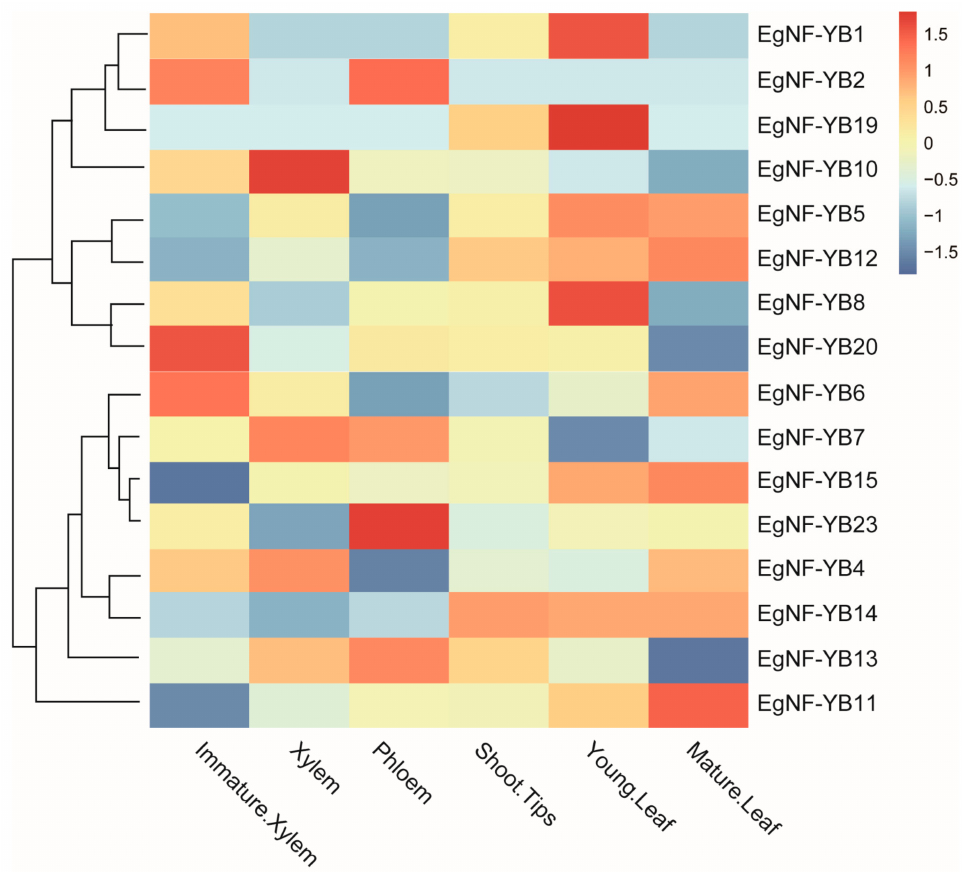
Figure 6. Expression patterns of 16 EgNF-YB genes in immature xylem, xylem, phloem, shoot tips, young leaf and mature leaf of eucalyptus. Different colors in the map represent gene transcript abundance values as shown in the bar by the side of the